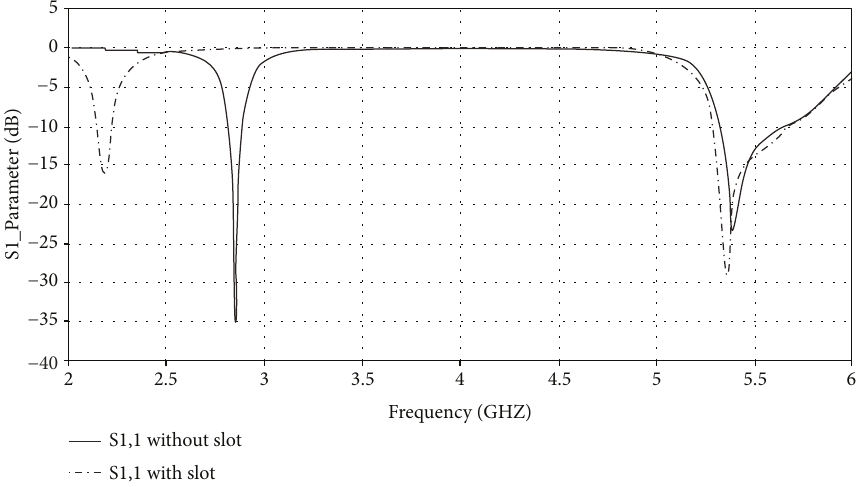
Figure 9: S 11 parameter of the antenna without slot and with slot.